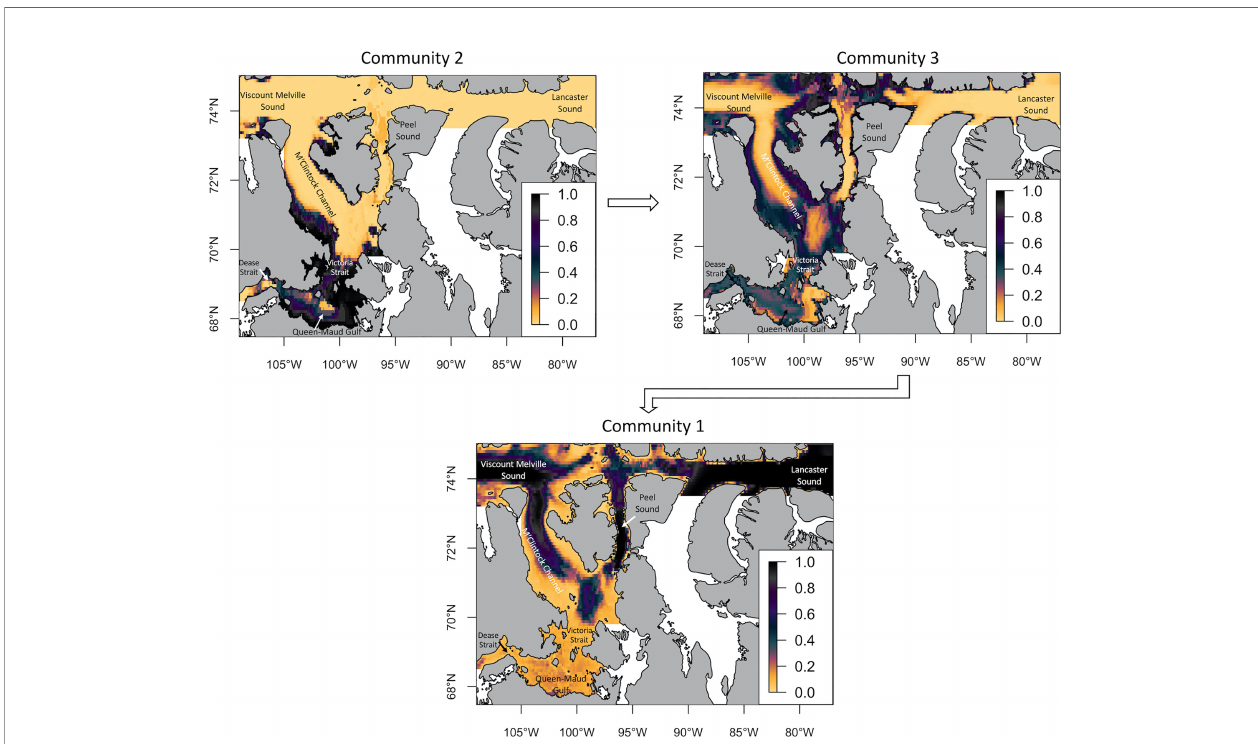
FIGURE 9 | Habitat suitability of the 3 epifauna groups in the Kitikmeot sea region and Parry Channel obtained with GLMs. The scale from 0 to 1 represents the probability of occurrence of the community. The arrows show the proposed gradient of species assemblage from Dease Strait to Lancaster